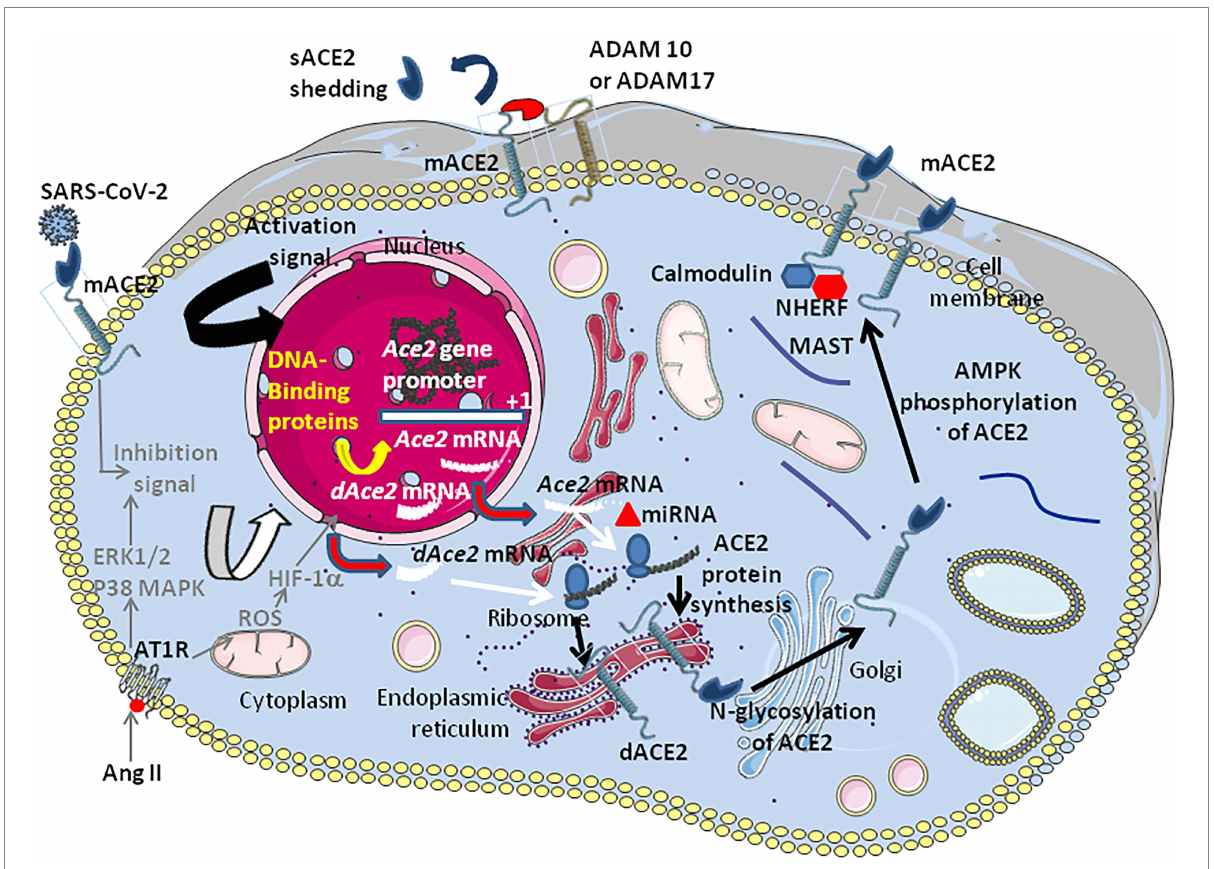
FIGURE 5 Schematic representation of the regulation of ACE2 expression. The transcription of the Ace2 gene is under control of several DNA-binding proteins that bind the Ace2 gene promotor (see Figure 3). In patients with hypertension (hypertensive cardiopathy and hypertensive nephropathy) a down-regulation ACE2 is observed. Angiotensin II was shown to down-regulate ACE2. The inhibition of ACE2 expression was shown to be associated with the activation of ERK and p38 MAP kinases (however this signaling pathway also activates NF- κ B which is an activator of ACE2 , suggesting a complex regulation of positive and negative signals which remains to be characterized). The binding of AngII to AT1R induces the hypoxia-inducible factor (HIF)-1 α , which regulates several genes involved in the RAS (e.g., ACE1). Post-transcriptional regulation by miRNA (e.g., miRNA143 and miRNA421) could occur. Following translation the newly synthesized ACE2 proteins are target of post-transcriptional modifications such as phosphorylation of Ser680 by AMPK that enhances the stability of ACE2, and N-glycosylations (seven potential N-glycosylation sites). Once expressed at the cell membrane the mACE2 protein can be regulated by sheddases (e.g., ADAM10 and ADAM17) that cleave the ACE2 extracellular domain and release a circulating soluble form, sACE2. IFN β is likely to induce dominant expression of dACE2 over